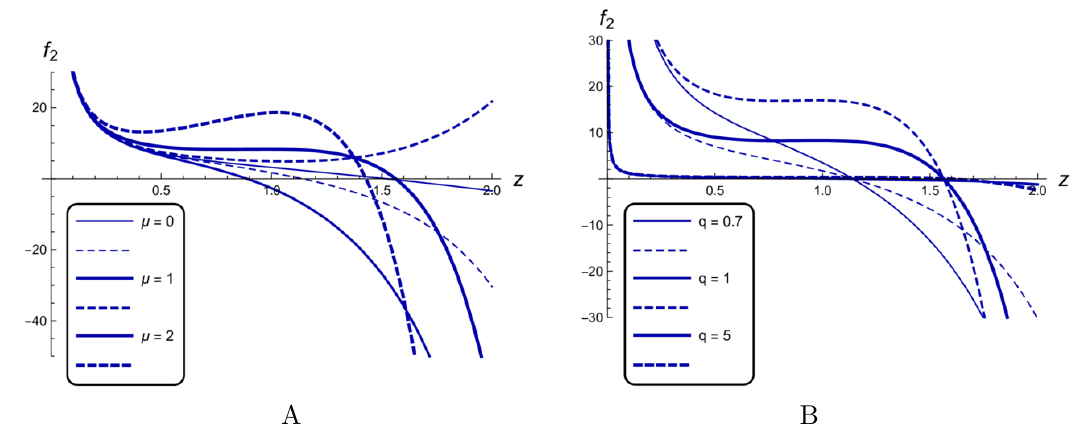
Figure 2 . Coupling function f 2 ( z ) (solid lines) and f 2 approx (same thickness dashed lines) for z h = 1, (cid:23) = 4 : 5, c = (cid:0) 1, q = 1, (cid:22) = 0 ; 1 ; 5 (A) and (cid:22) = 1, q = 0 : 7 ; 1 ; 5